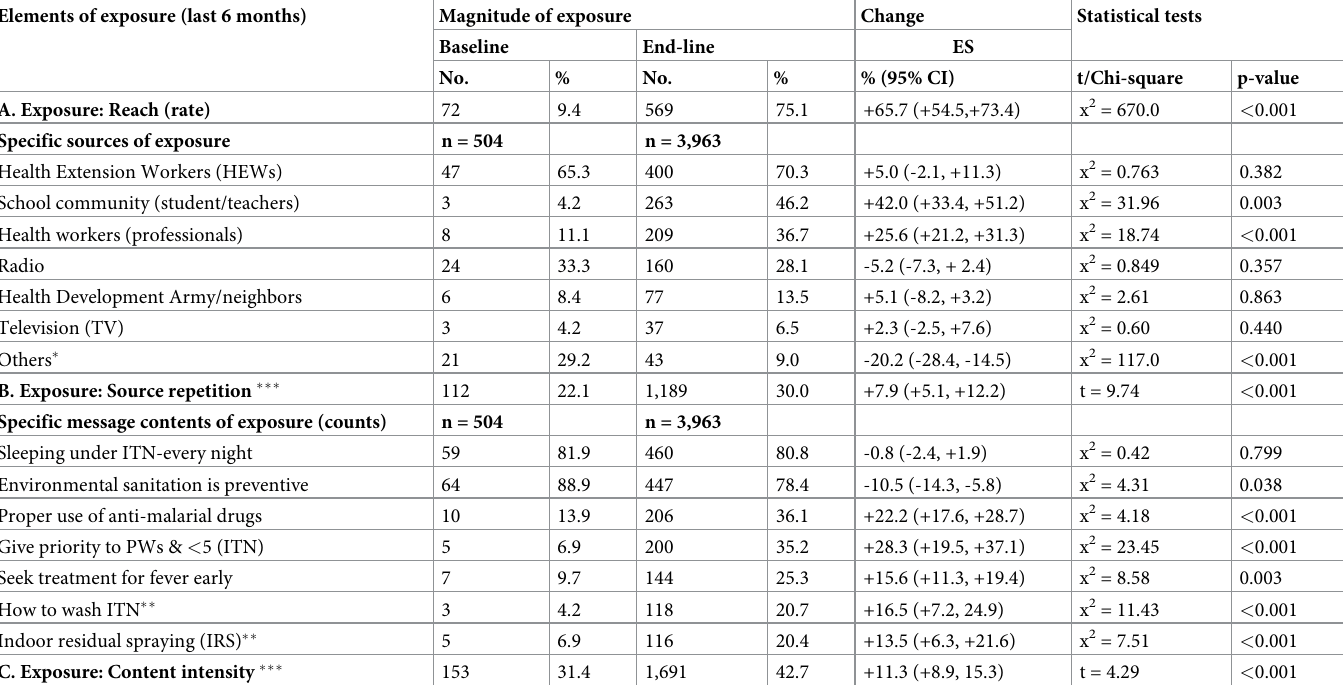
Table 2. Magnitude of changes in community exposure to malaria messages, Jimma Zone, SBCC target districts, 2017–19 (Baseline, n = 762; End-line, n =